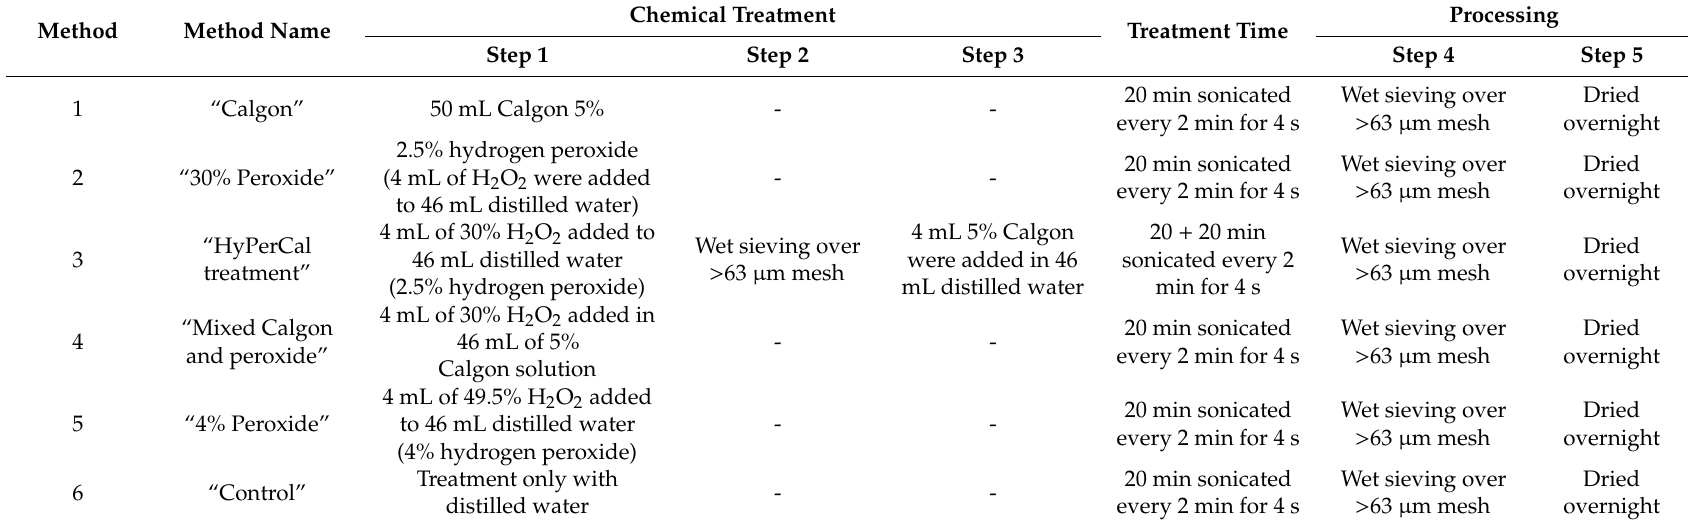
Table 1. Table summarizing the di ff erent cleaning methods